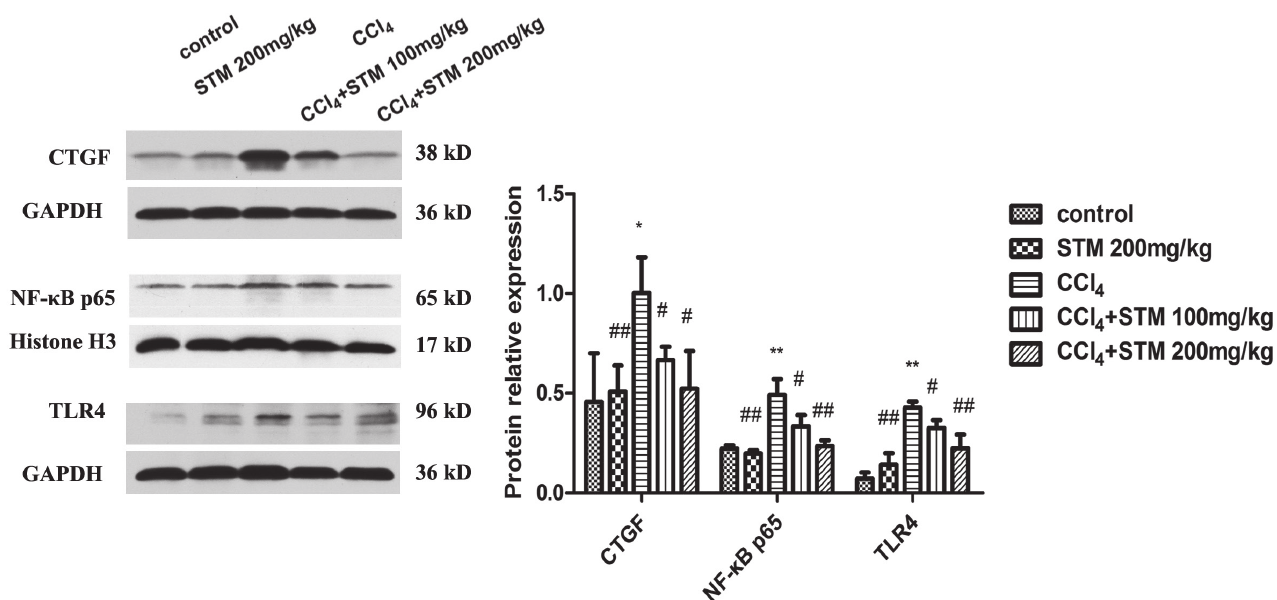
FIGURE 4 - STM repressed the protein expression of CTGF, TLR4 and NF-κB p65 in the liver. The CTGF protein level of rats in CCl +STM 100 mg/kg and CCl +STM 200 mg/kg groups were downregulated significantly compared with the CCl4 group. The 4 4 protein expression of TLR4 and NF-κB p65 of rats in CCl +STM 100 mg/kg and CCl +STM 200 mg/kg groups were significantly 4 4 lower than that in the CCl group. Data are represented as means ± S.D for 3-4 animals per group. * p < 0.05 versus control, ** p < 4